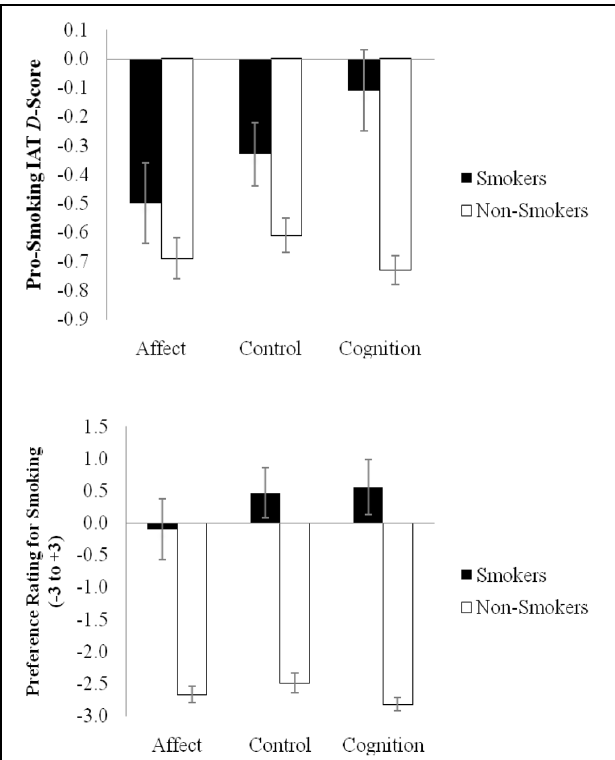
FIGURE 1 | IAT D -scores (top) and preference ratings (bottom) for smoking as a function of smoking status and the type of persuasive message in Study 3. Positive scores indicate a preference for smoking. Error bars indicate the 95% confidence interval around the